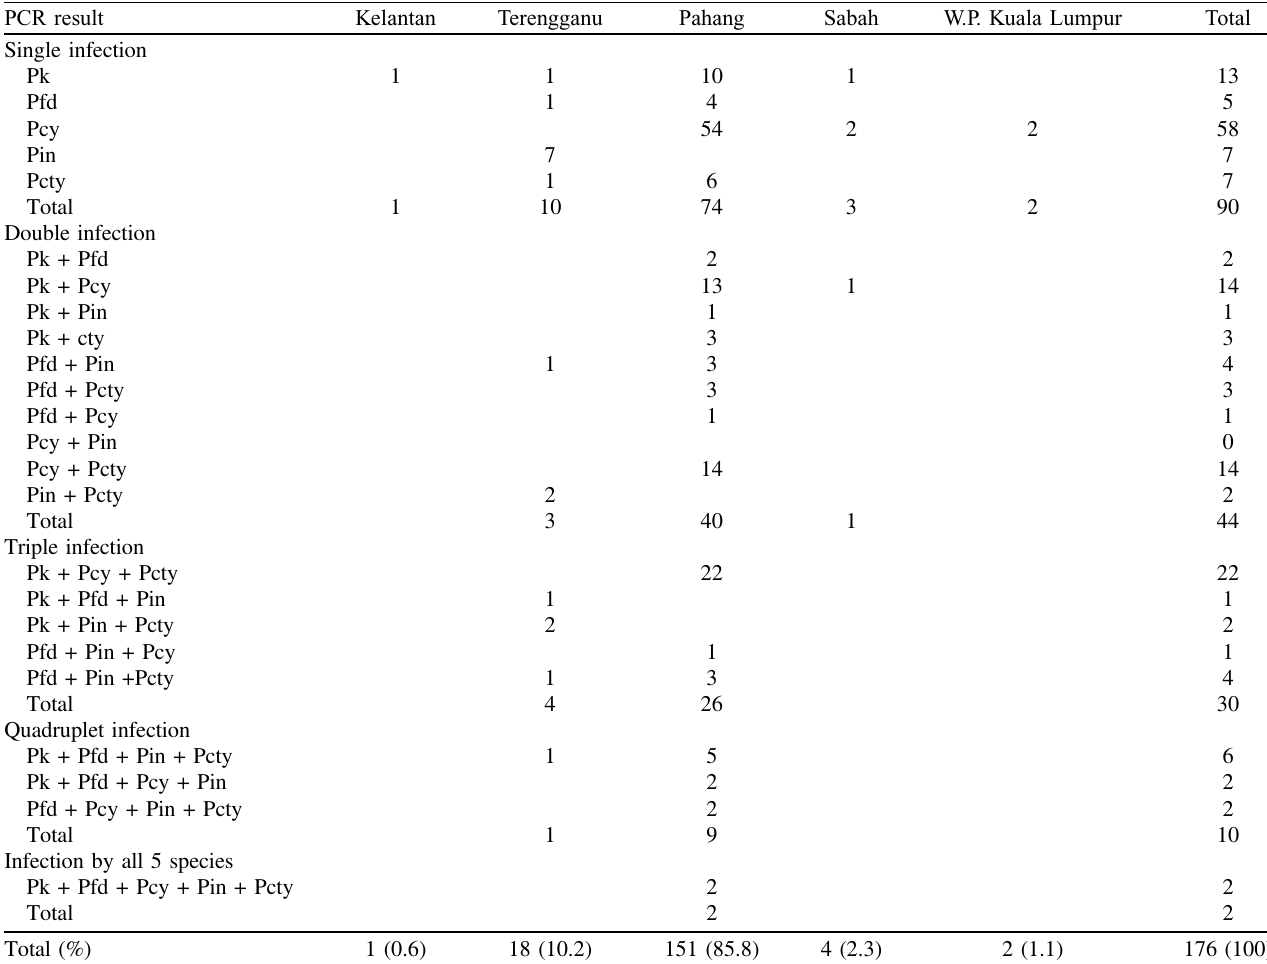
Table 2. Prevalence of simian malaria among macaque populations in Malaysia. PCR